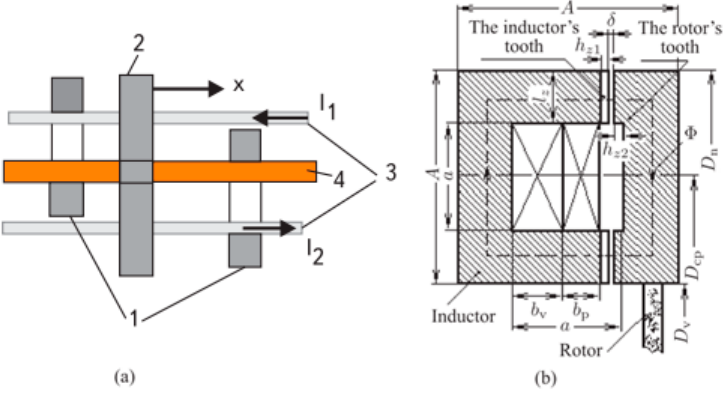
Figure 2. The elementary module of a machine with magnetic commutation: ( a ) principle of operation; ( b ) designations of geometric dimensions.